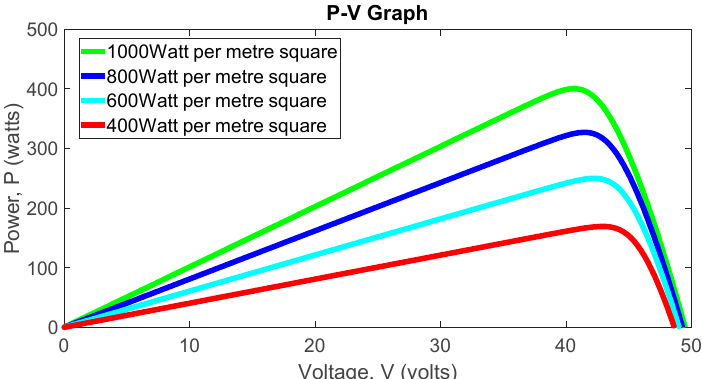
Figure 11. Simulated PV curve using the Hybrid BESSA technique for Module AS ‐ M3607 ‐ S (G1 CELLS) at varying irradiances while keeping temperature fixed at 25 °C.